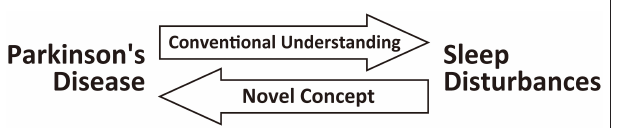
FIGURE 1 | Bidirectional relationship between sleep disturbances and Parkinson’s disease (PD). Sleep disturbances, especially insomnia, are one of the most common non-motor symptoms in patients with PD and otherwise healthy older adults. The conventional understanding is that PD pathology and various PD-related motor or non-motor symptoms induce sleep disturbances in patients with PD (upper arrow). In contrast, recent epidemiological and experimental studies have suggested that sleep disturbances impact the susceptibility to developing or the progression of PD (lower arrow). These are not mutually exclusive and could form a vicious cycle in which sleep disturbances caused by PD pathology in turn accelerate the PD pathology.